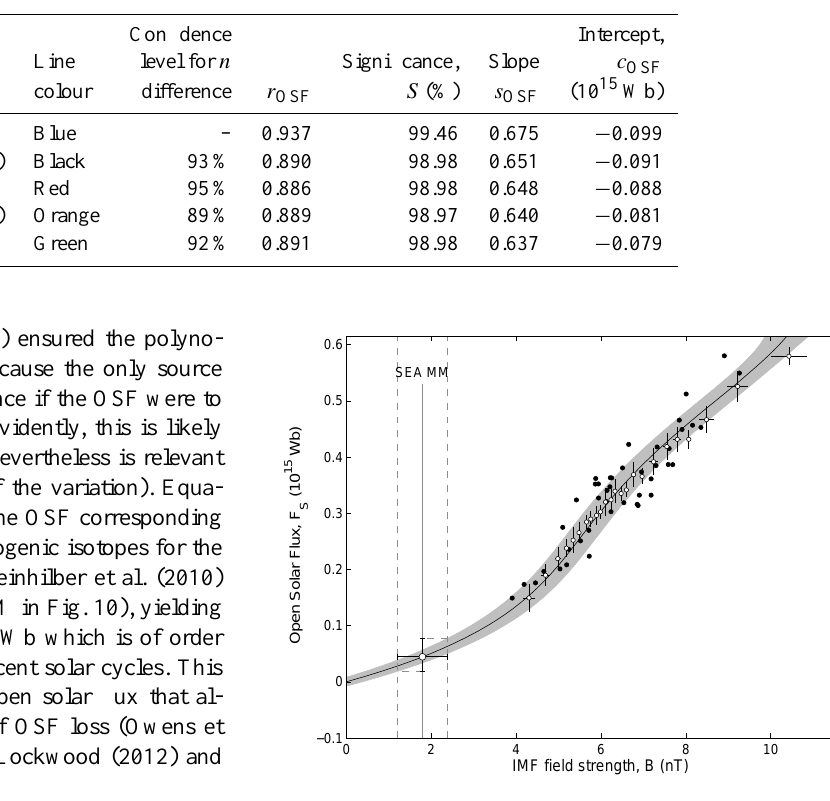
Fig. 10. Plot of signed, kinetically corrected OSF, F S , as a func- tion of the near-Earth IMF, B . The filled circles are annual means of in situ satellite observations. The open circles are means of 25 samples from all four geomagnetic index combinations (grouped by sorted B) with error bars in both B and F s of plus and minus one standard deviation. The black line is the polynomial fit used by Lockwood et al. (2009c) and the surrounding grey area is the uncertainty band. The band marked SEA MM is the mean value of B for the end of the Maunder minimum deduced from cosmo- genic isotopes by Steinhilber et al. (2010) from which the best es- timate of the mean for the end of the Maunder minimum F S is ( 0 . 48 ± 0 . 29 ) × 10 14